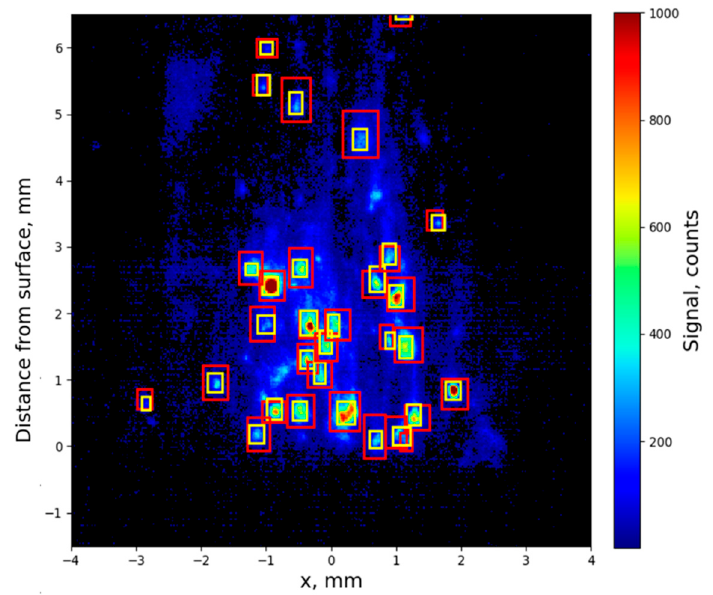
Figure 6. Zoom on the central part of the flame. The yellow boxes give the position of the manual spotting of the droplets and the red boxes display the result of the maximally stable extremal regions (MSER) algorithm treatment.